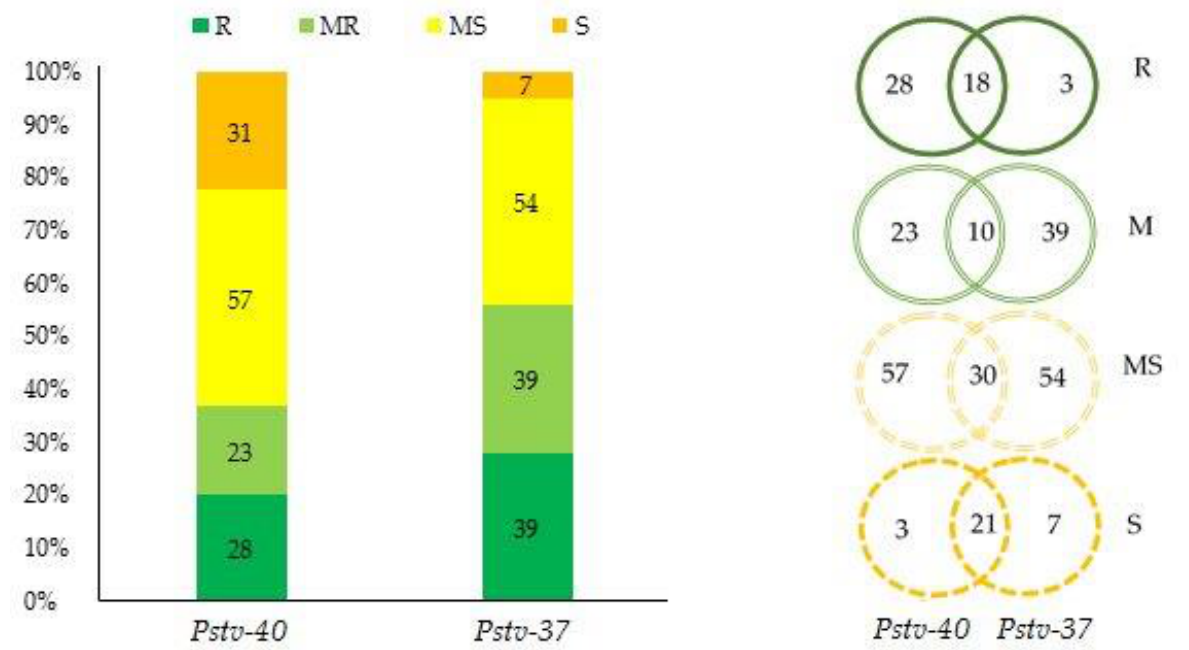
Figure 1. Summary of the frequency distribution for stripe rust reaction in 139 durum wheat accessions to two races of Pst at the seedling stage.